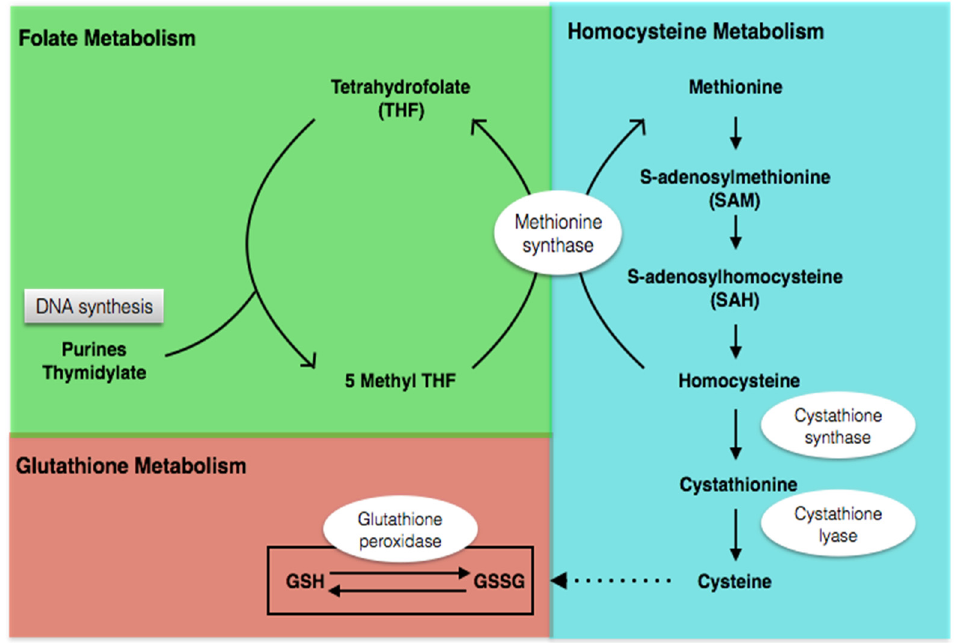
Figure 1. Folate, homocysteine, and glutathione metabolism.